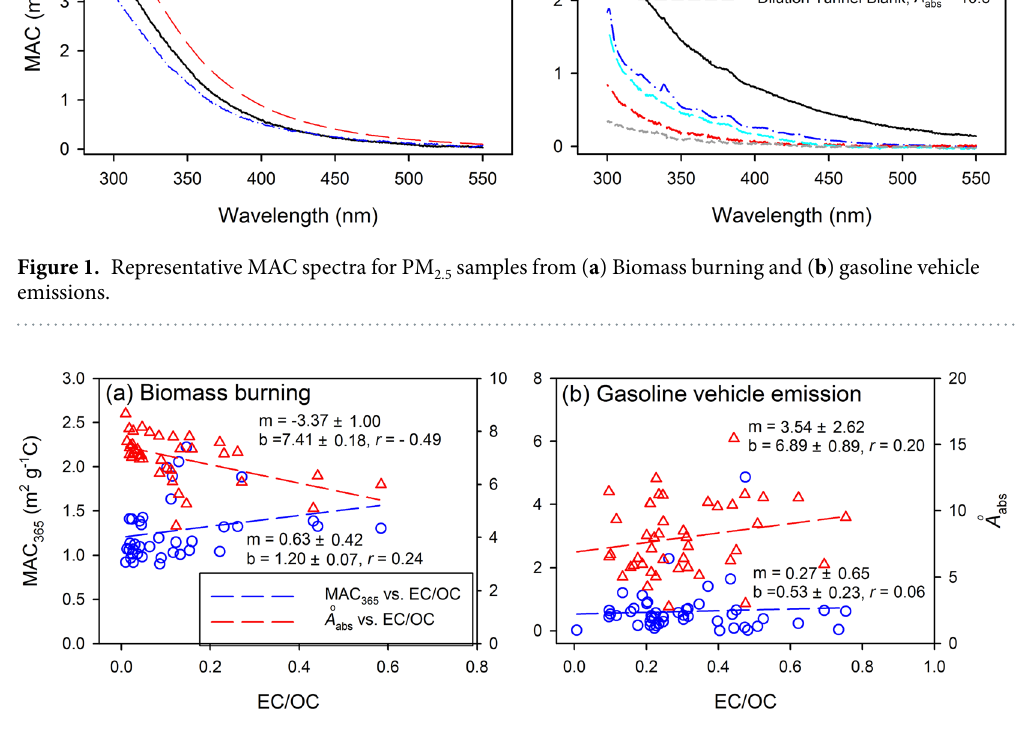
Figure 2. Linear regressions of MAC 365 vs. EC/OC, and Å abs vs. EC/OC for ( a ) prescribed and laboratory biomass burning and ( b ) gasoline vehicle emissions. In each plot, m and b represent regression slope and intercept, respectively, with one standard